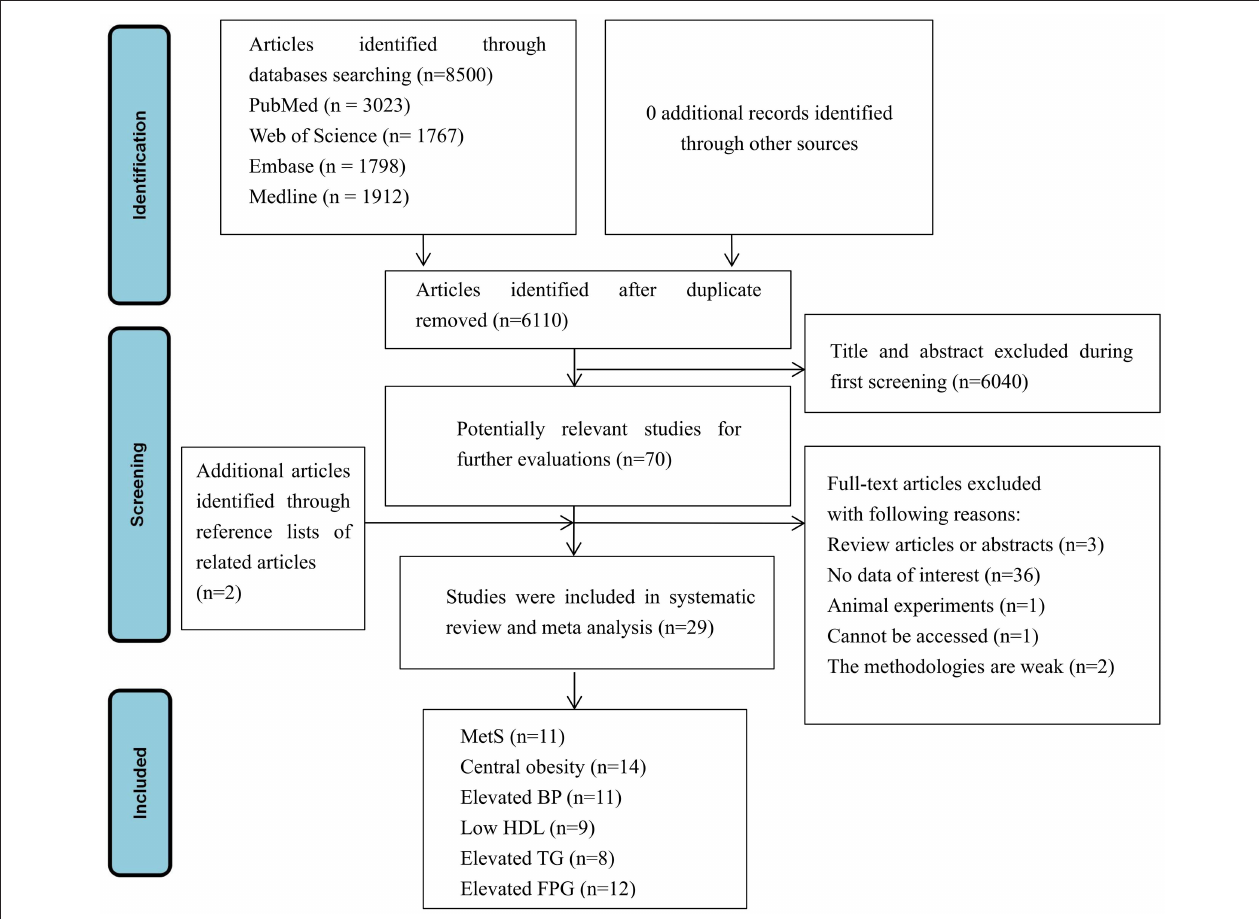
FIGURE 1 | Flow chart of the selection process of the eligible studies. MetS, metabolic syndrome; BP, blood pressure; FPG, fasting plasma glucose; TG, triglycerides; HDL, high-density lipoprotein.